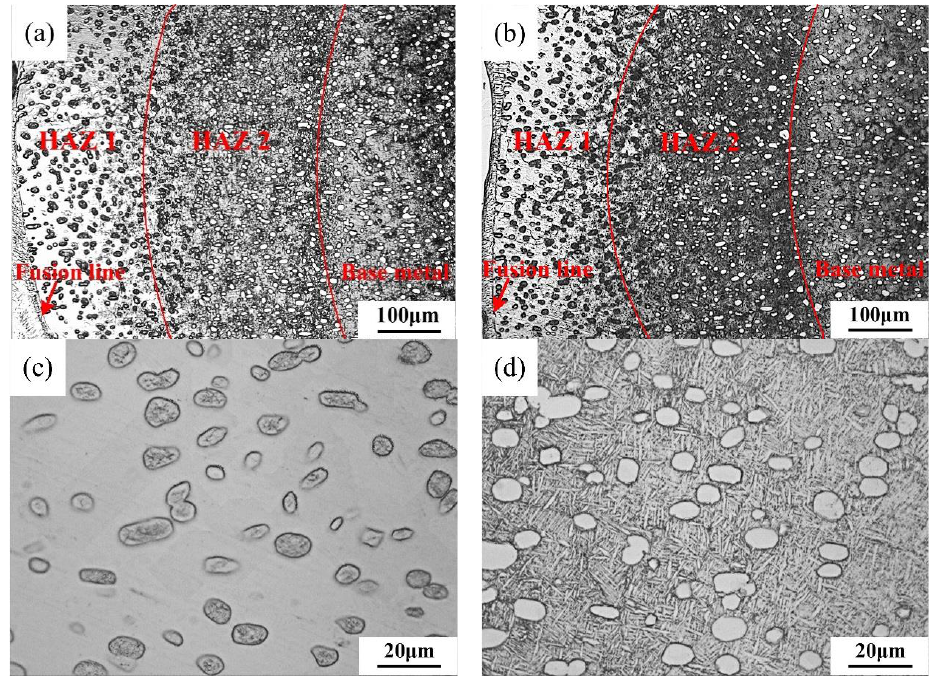
Figure 9. Microstructures of heat-affected zones (HAZs): ( a ) HAZ without filler metal; ( b ) HAZ with Nb filler metal; ( c ) microstructure of HAZ1 and ( d ) microstructure of HAZ2.